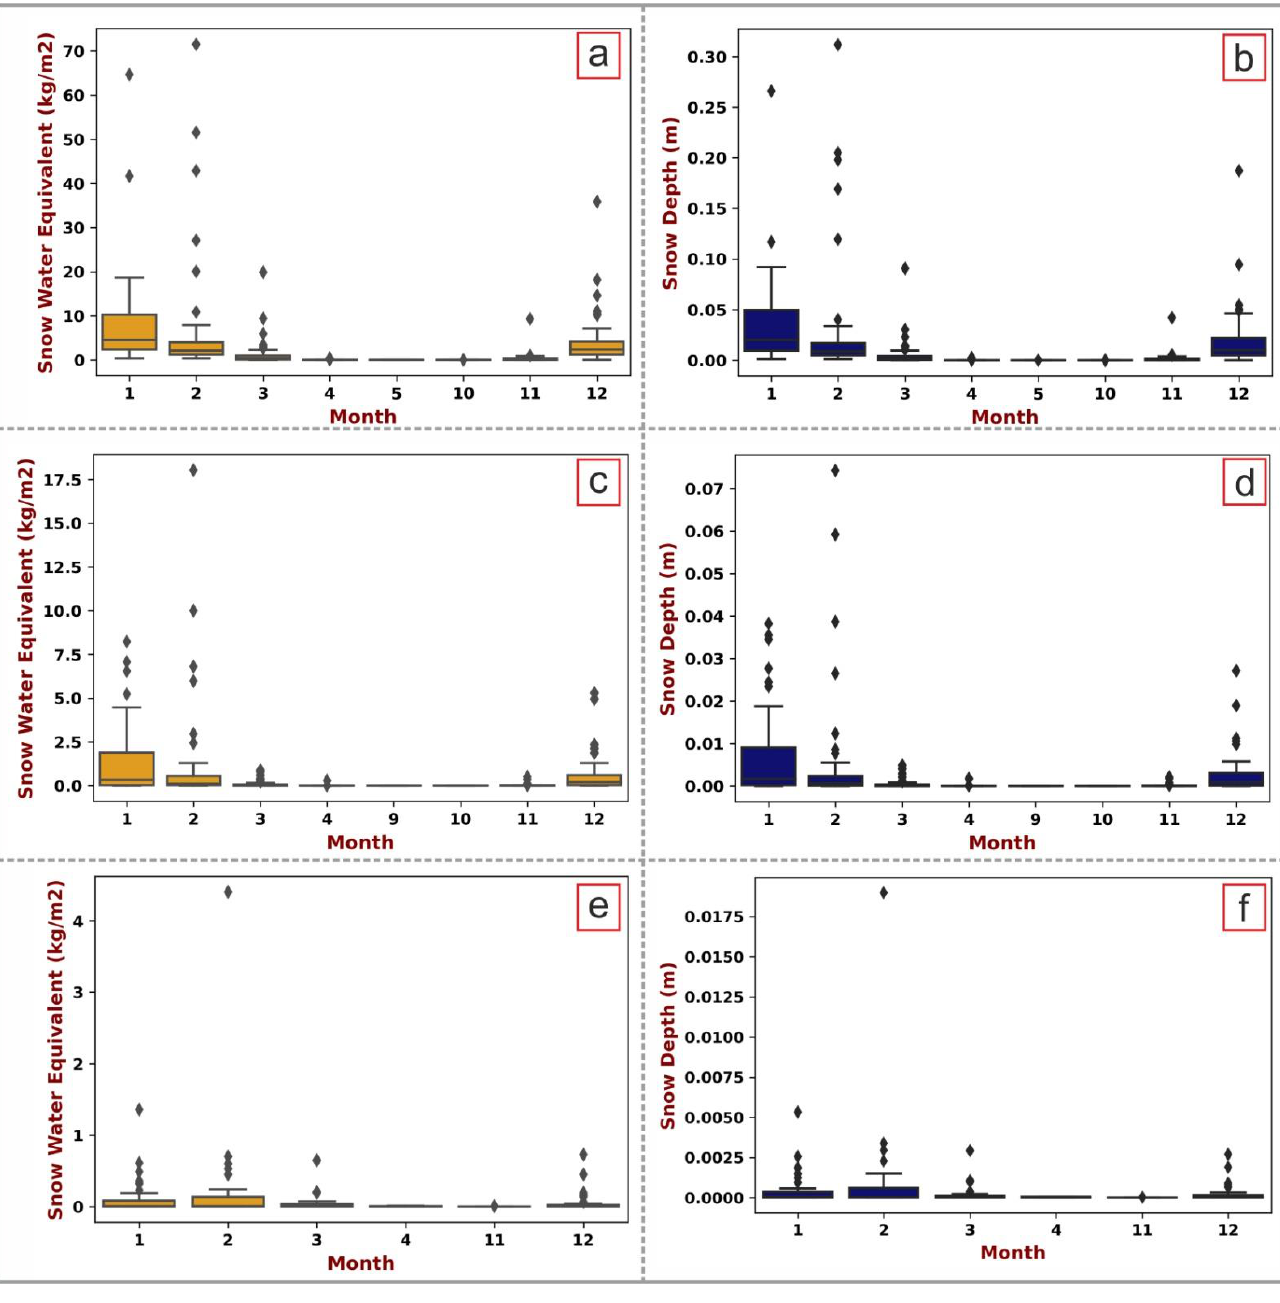
Figure 7. The annual cycle of the monthly mean snow parameters: ( a ) SWE in Anthemountas basin, ( c ) SWE in Mourikibasin, ( e ) in Upper Volturno-Calore basin, ( b ) SD in Anthemountas basin, ( d ) SD in Mouriki basin, and ( f ) in Upper Volturno-Calore basin, during the period 1960 – 2021. Boxplot whiskers correspond to the most distant value encountered within 1.5 times the interquartile range above the upper and lower quartiles.